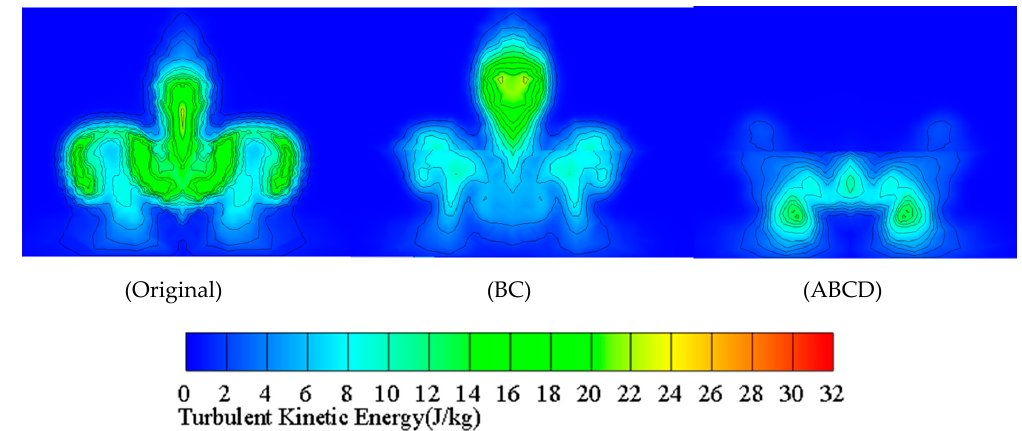
Figure 16. Turbulent kinetic energy contour on x = 0.6 m section (15 kV).